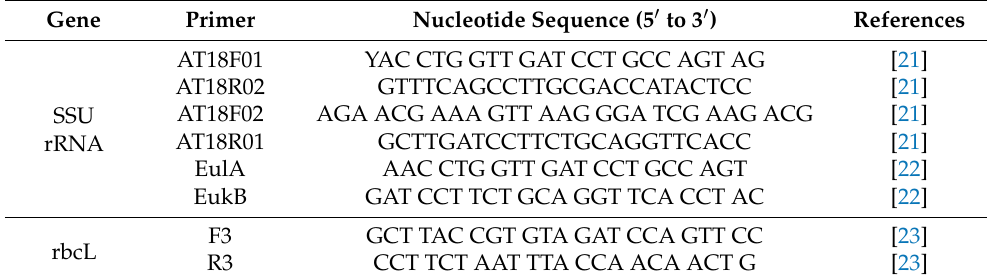
Table 1. Primers used for amplification and sequencing of the nuclear SSU rRNA and rbcL. Gene Primer Nucleotide Sequence (5 (cid:48) to 3 (cid:48) )